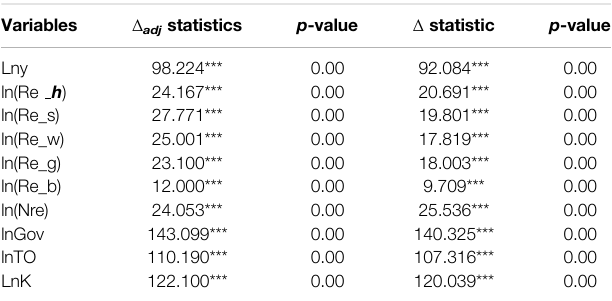
TABLE 2 | Heterogeneous panel analysis.